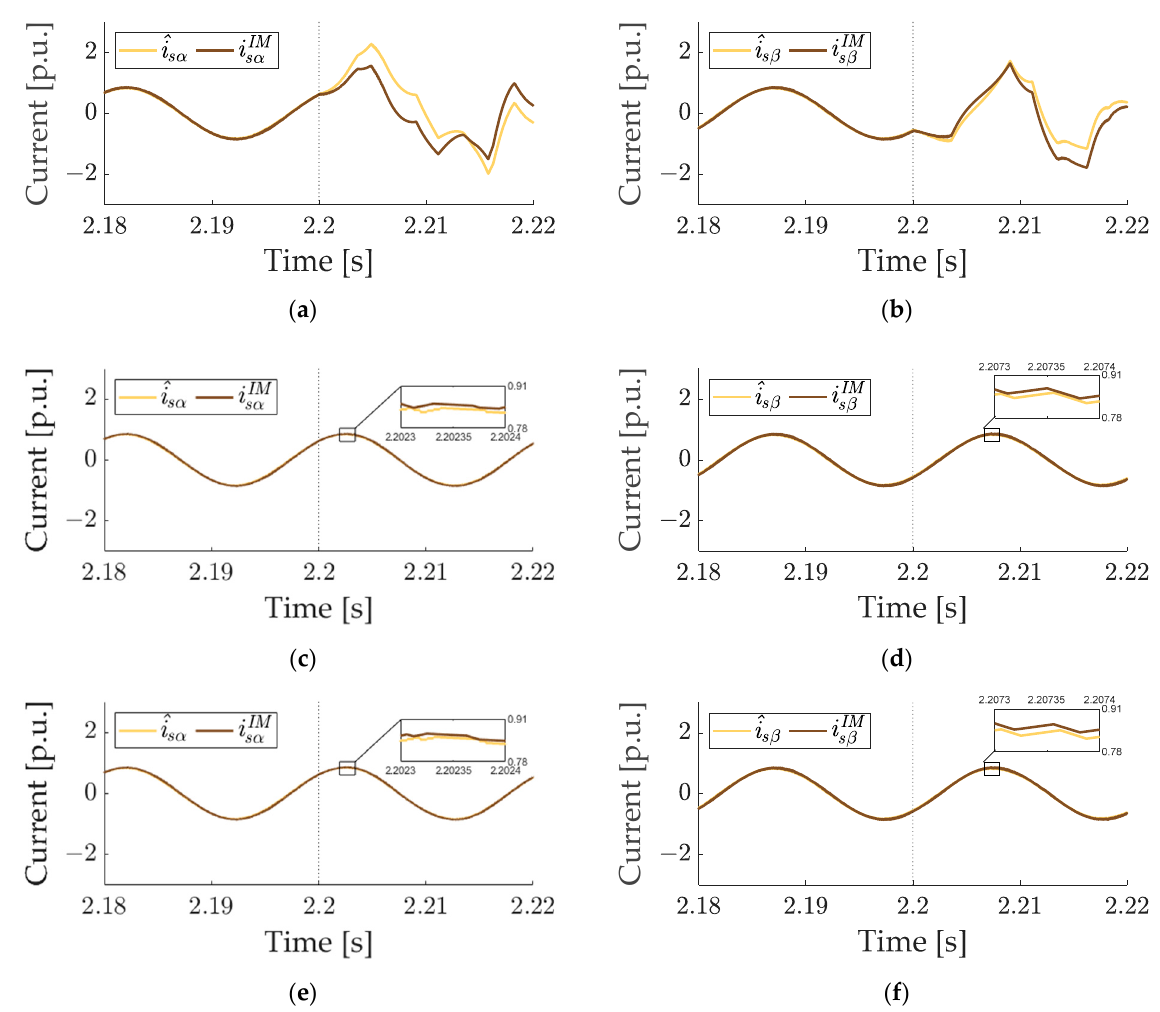
Figure 8. Estimated and IM components α ( a , c , e ) and β ( b , d , f ) of the stator current vector for k 0 = 0.6 and faulty CS in phase A : ( a , b ) variant v 1 , ε i = 0.4702; ( c , d ), variant v 2 , ε i = 0.0167; ( e , f ), variant v 3 , ε i = 0.01425.